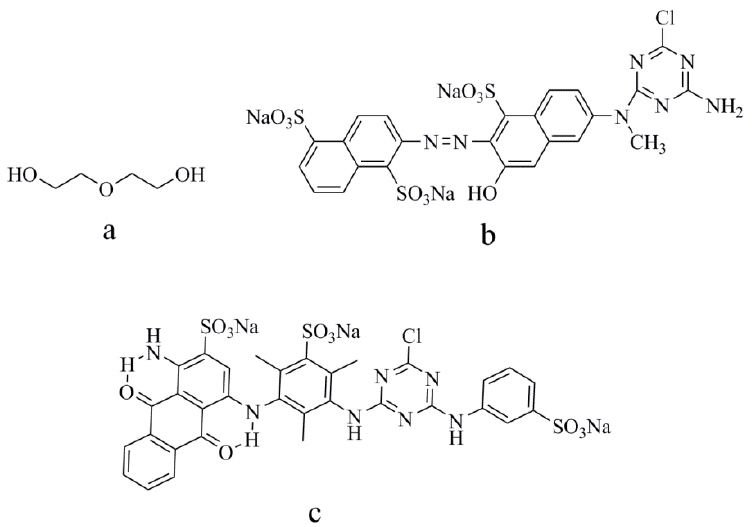
Figure 1. Chemical structures of: ( a ) diethylene glycol (DEG), ( b ) Reactive Orange 13, and ( c ) Reactive Blue 49.